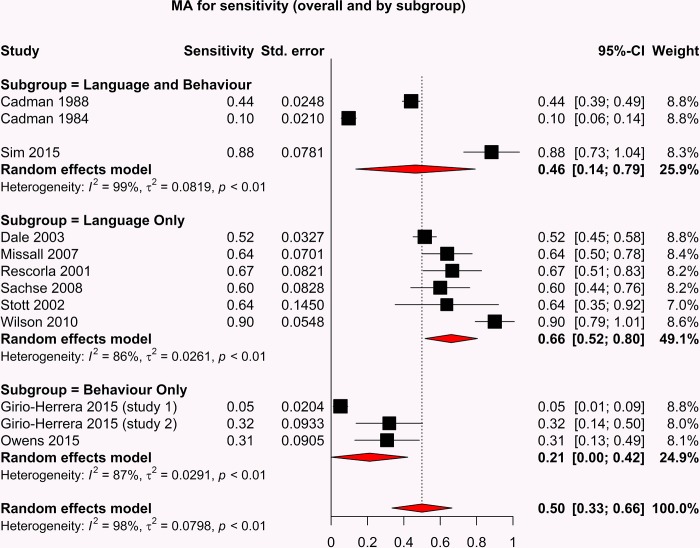
Sensitivity forest plot.